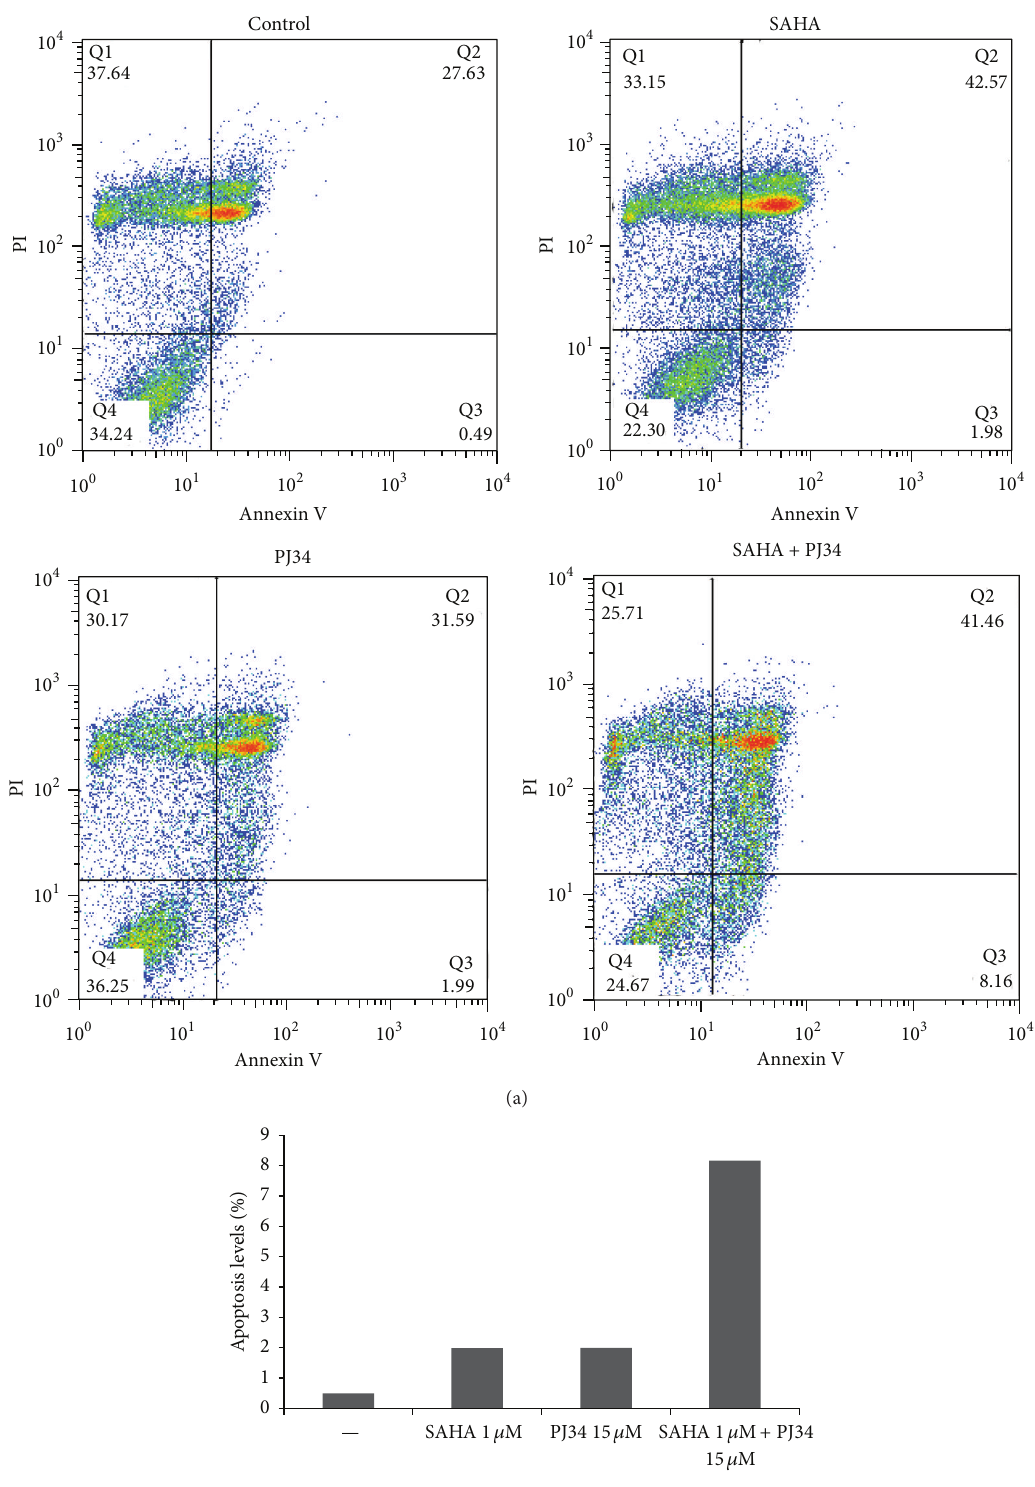
Figure 3: Combination of SAHA and PJ34 induces apoptosis in SW1736 cell line. In (a) Annexin V (FITC) and propidium iodide (PI) staining of anaplastic thyroid cancer cell line after 72 h treatment with SAHA 1 𝜇 M, PJ34 15 𝜇 M alone or in combination. In (b) representation of Annexin V-positive/PI-negative